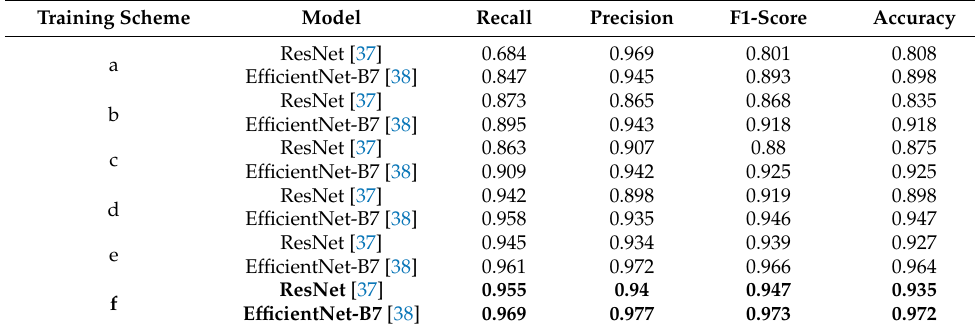
Table 2. Data Augmentation Experiments on Surface Defect